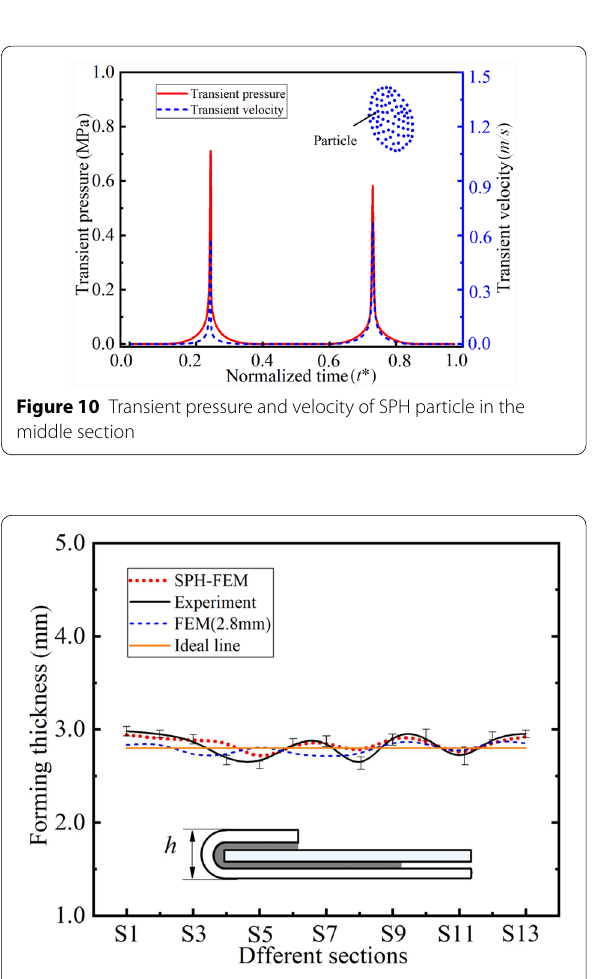
Figure 11 Forming thickness and surface wave after final